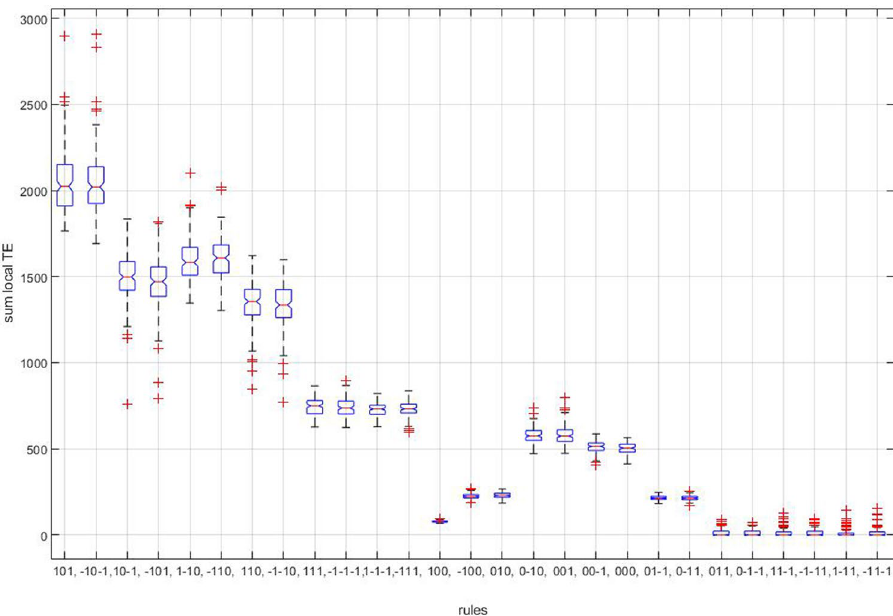
Figure 6. Post-hoc analysis of ANOVA one way. The distribution of local TE in the 27 different rules (see the text for details) shows that the first eight rules form a cluster independent from the others.